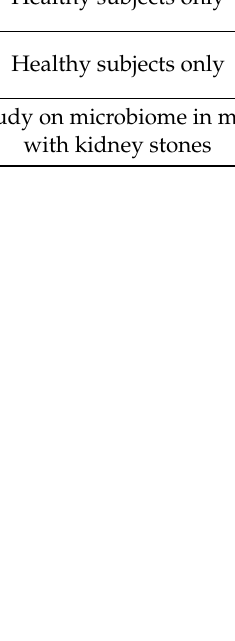
Table 2. Urinary microbiome in bladder cancer